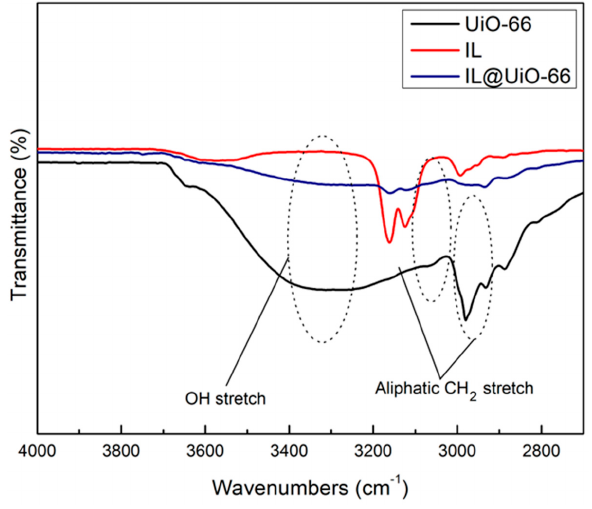
Figure 10. FTIR spectrum of UiO-66, IL and IL@UiO-66 from 4000 to 2700 cm − 1 .